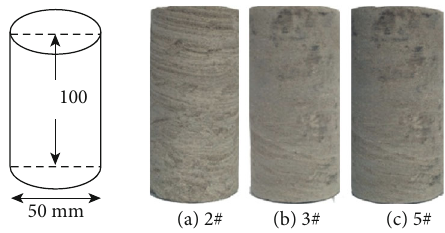
Figure 12: Gray sandstone samples from a coal mine in